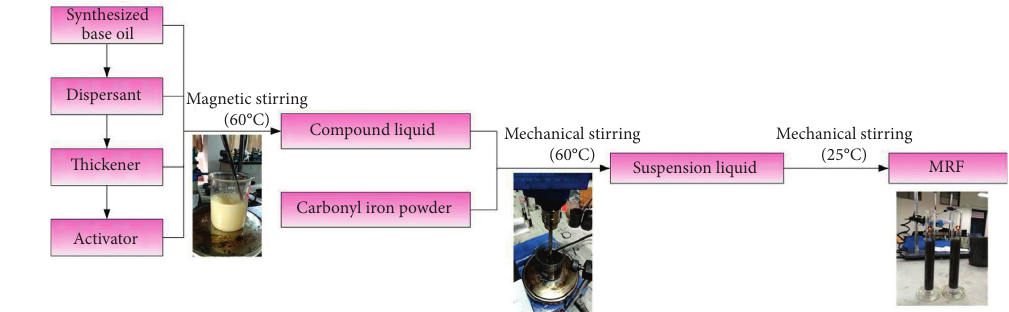
Figure 1: Preparation process of MRF.